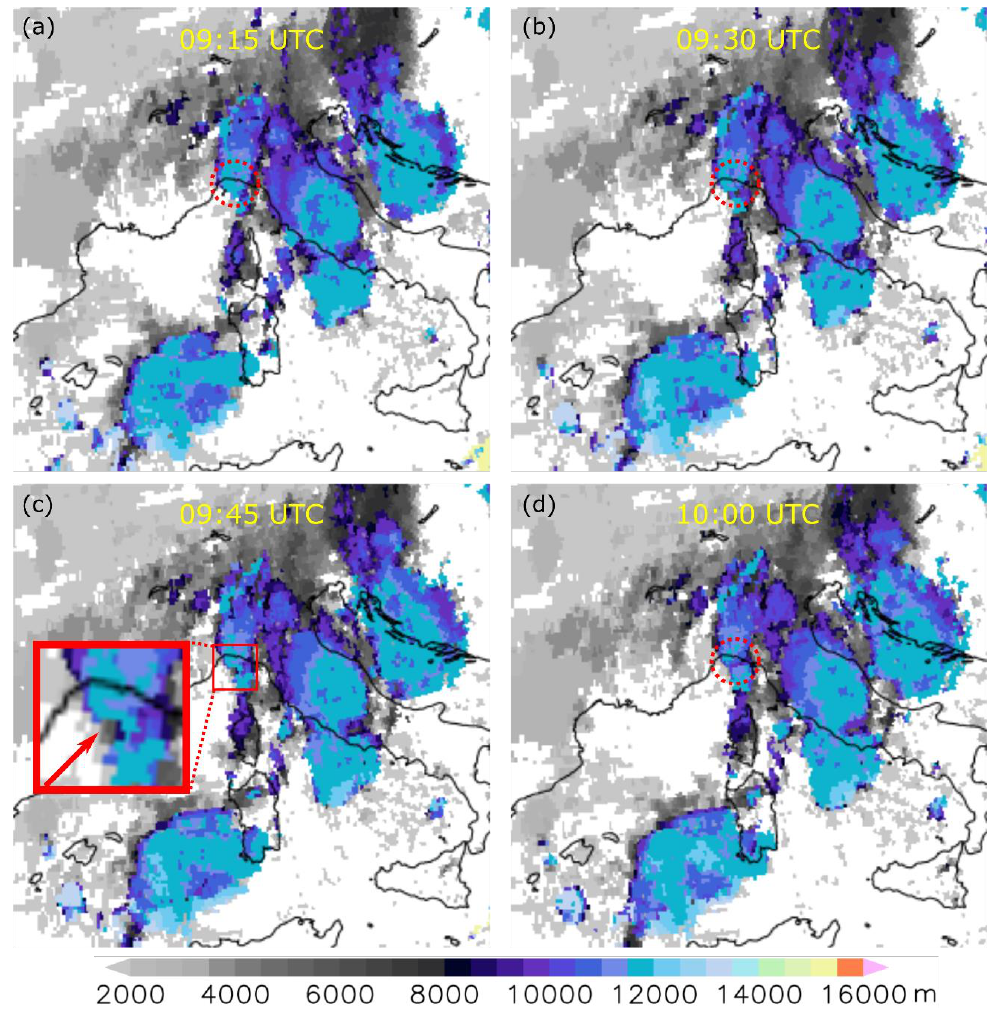
Figure 4. Cloud top heights above Italy and surrounding regions from the MSG (Meteosat Second Generation) satellite data. The retrieval time of images, every 15-min from 0915 UTC ( a ) to 1000 UTC ( d ), is indicated in each plot and the red (dashed) circle represents a wider region around Genoa.